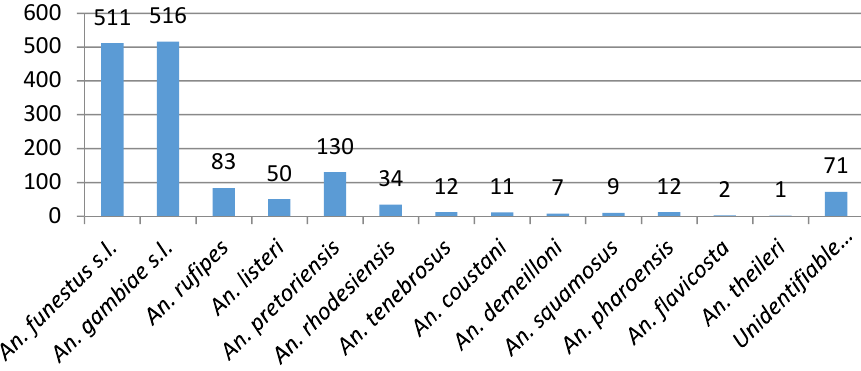
Figure 4. Mosquito numbers by Anopheles species: adults and larvae collected October 2017 to October 2018.